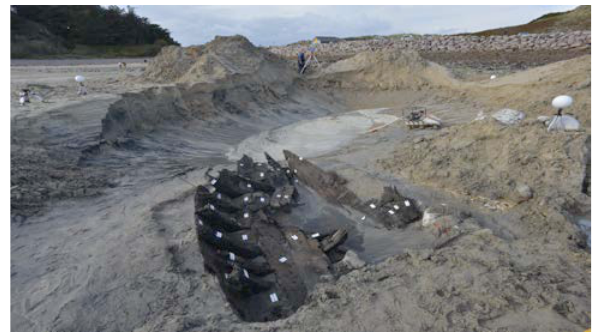
Figure 3. The wreck “Les Hôpitaux” (F.Osada/Drassm)